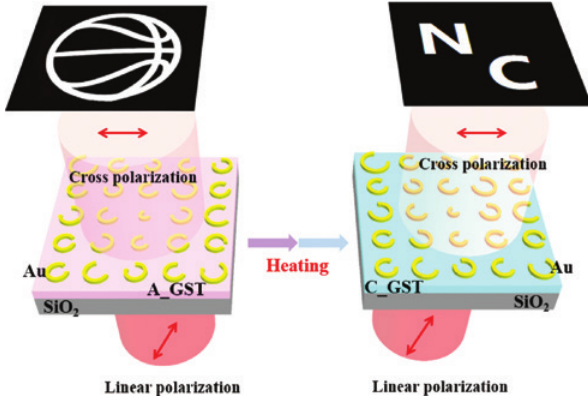
Figure 1: Schematic of double holographic encryption based on hybrid metasurface under amorphous and crystalline